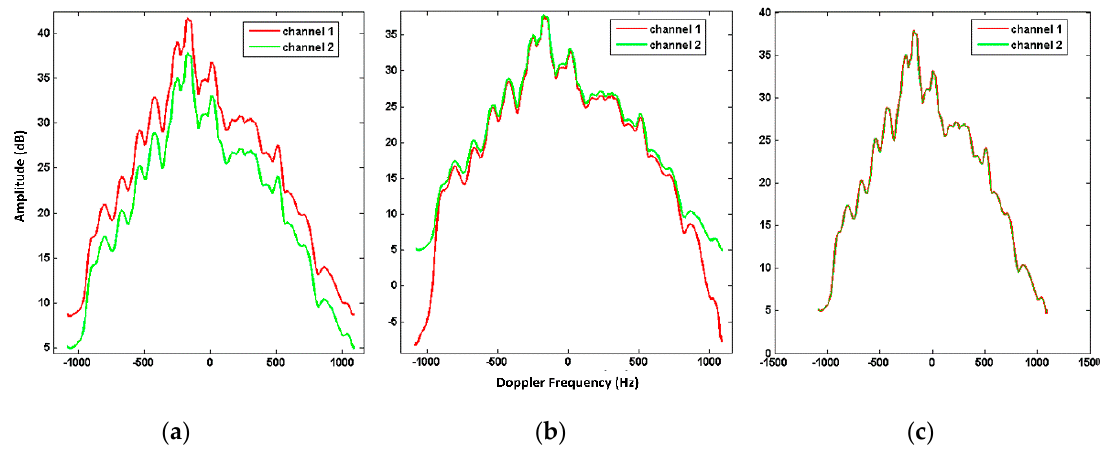
Figure 5. The amplitude curves of the dual-channel signals: ( a ) after channel registration, ( b ) after 2D calibration, and ( c ) after 2D calibration and amplitude equalization.